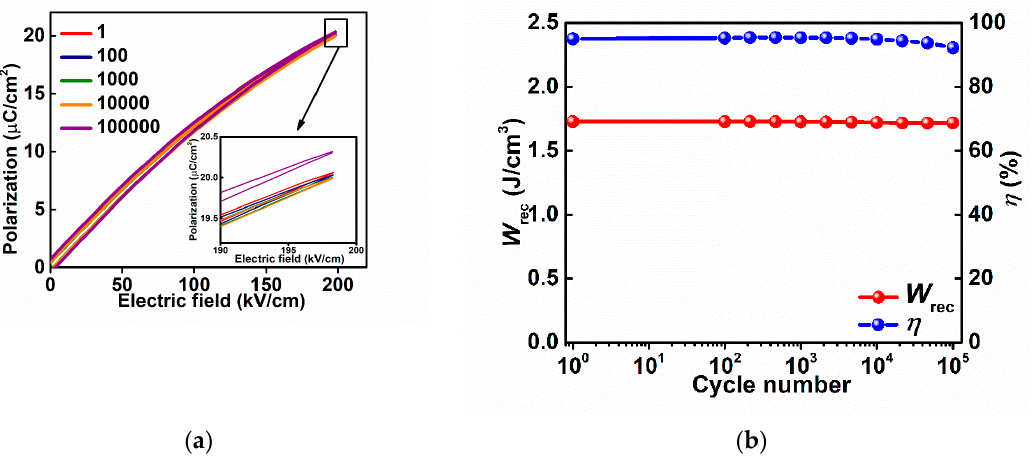
Figure 7. ( a ) Unipolar P – E loops for 6BMZ ceramic under different fatigue cycling number; ( b ) W r and η as functions of charging–discharging cycles from 1 to 10 5 for 6BMZ ceramic.